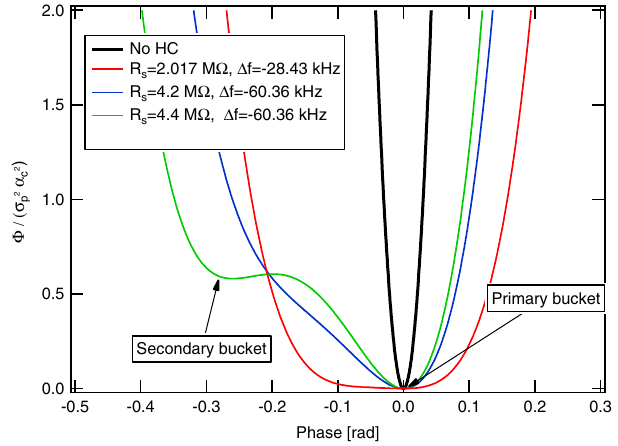
FIG. 7. Potential distribution for various settings of the har- monic cavity. The (approximately parabolic) potential when no harmonic cavity is present is also shown for comparison.